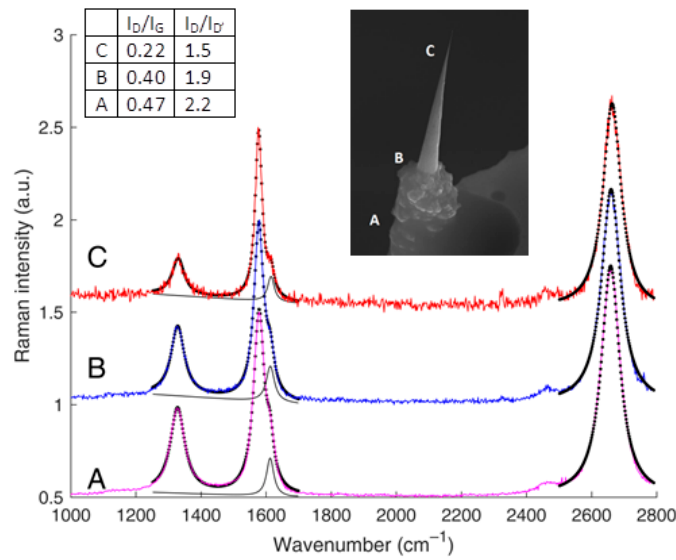
Figure 8. Raman spectra (the D’ contribution to the fit is also plotted as the thin, solid black line) of a carbon cone at the various positions indicated on the image in the inset. Top left: values of both I D / I G and I D / I D’ ratios.